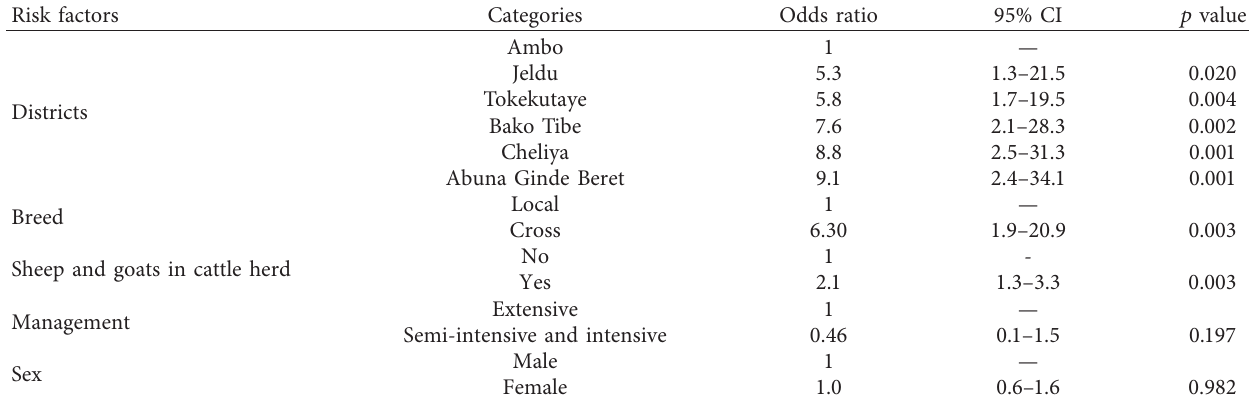
Table 2: Results of the multivariable logistic regression model for the predictors of seropositivity of bovine FMD in the West Shewa Zone. Risk factors Categories